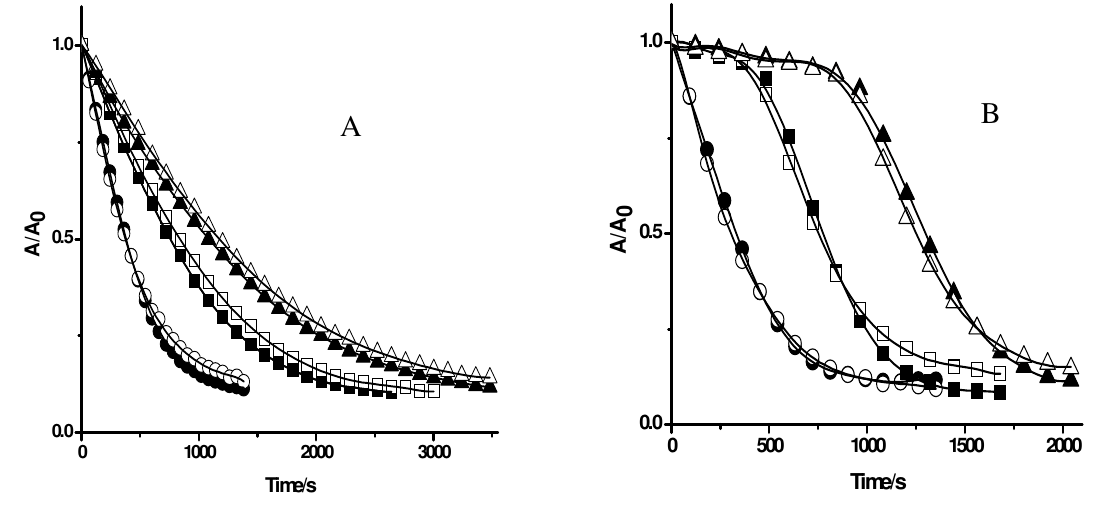
Figure 3. Effect of β -carotene on the consumption of PGR induced by AAPH derived peroxyl radicals. PGR (5 µM) was incubated with AAPH (10 mM) and Triton X-100 (50 mM) in the absence and presence of β -carotene (5 µM). The reaction was followed by the consumption of PGR ( (cid:2) , 550 nm) and β -carotene ( (cid:1) , 460 nm). Control experiment without β -carotene ( (cid:1)